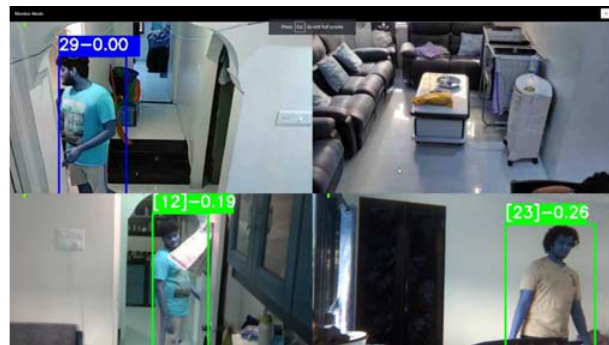
Fig17: Green box and persistence of the person on